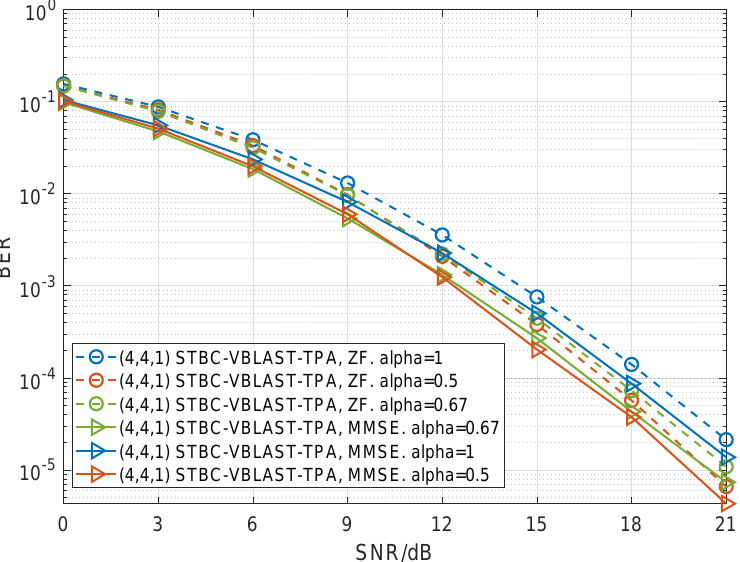
Figure 8. Performance comparisons of the ( 4,4,1 ) STBC-VBLAST-TPA system with α = 1, α = 0.5 and α = 0.667, employing MMSE and ZF